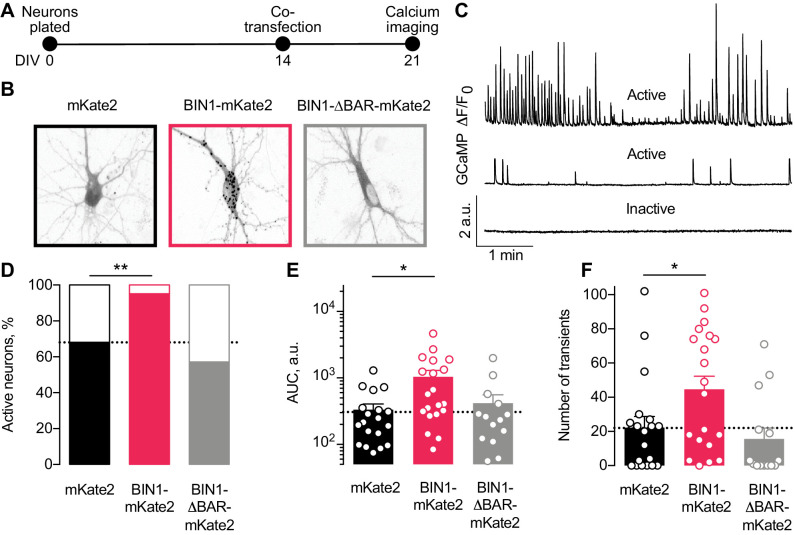
Higher BIN1 levels in mature neurons increase calcium influx in primary hippocampal neuronal cultures.(A) Calcium imaging experimental timeline: neurons were plated on DIV 0, co-transfected on DIV 14 with GCaMP6f calcium indicator and either BIN1-mKate2, BIN1-ΔBAR-mKate2, or mKate2 control construct, and recorded on DIV 21. n = 14–20 neurons per condition. (B) mKate2 fluorescence in primary transfected primary hippocampal neurons. BIN1-mKate2 fluorescence was punctate in transfected neurons. mKate2 and BIN-BAR-mKate2 fluorescence was diffuse and filled the neuron. (C) GCaMP fluorescence intensity, F, relative to the quiescent period between transients, F0. Neurons were classified as either active (with a range of activity levels indicated by the top and middle traces) or inactive (no calcium transients during the 8 min recording, bottom trace). (D) BIN1, but not BIN1-ΔBAR, increased the proportion of active neurons (Binomial test, **p=0.0071). (E) BIN1, but not BIN1-ΔBAR, increased neuronal calcium influx measured as area under the curve (AUC; one-way ANOVA, p=0.0134; Dunnett’s posthoc, *p=0.0122). (F) BIN1, but not BIN1-ΔBAR, increased the number of calcium transients (one-way ANOVA, p=0.0144; Dunnett’s posthoc, mKate2 vs BIN1-mKate2 adjusted *p=0.0437). All data are expressed as mean ± SEM.